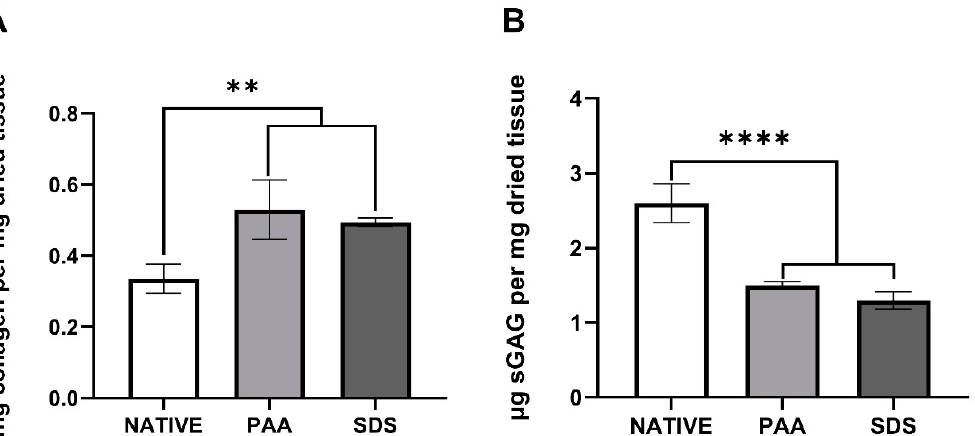
Figure 2. Biochemical composition of native and decellularized Urinary bladder matrix (UBM). ( A ) Collagen content (mg/mg) ( n = 4). ( B ) sGAG content ( μ g/mg) ( n = 6). ** and **** denote a statistically significant difference with p < 0.005 and 0.0001, respectively.